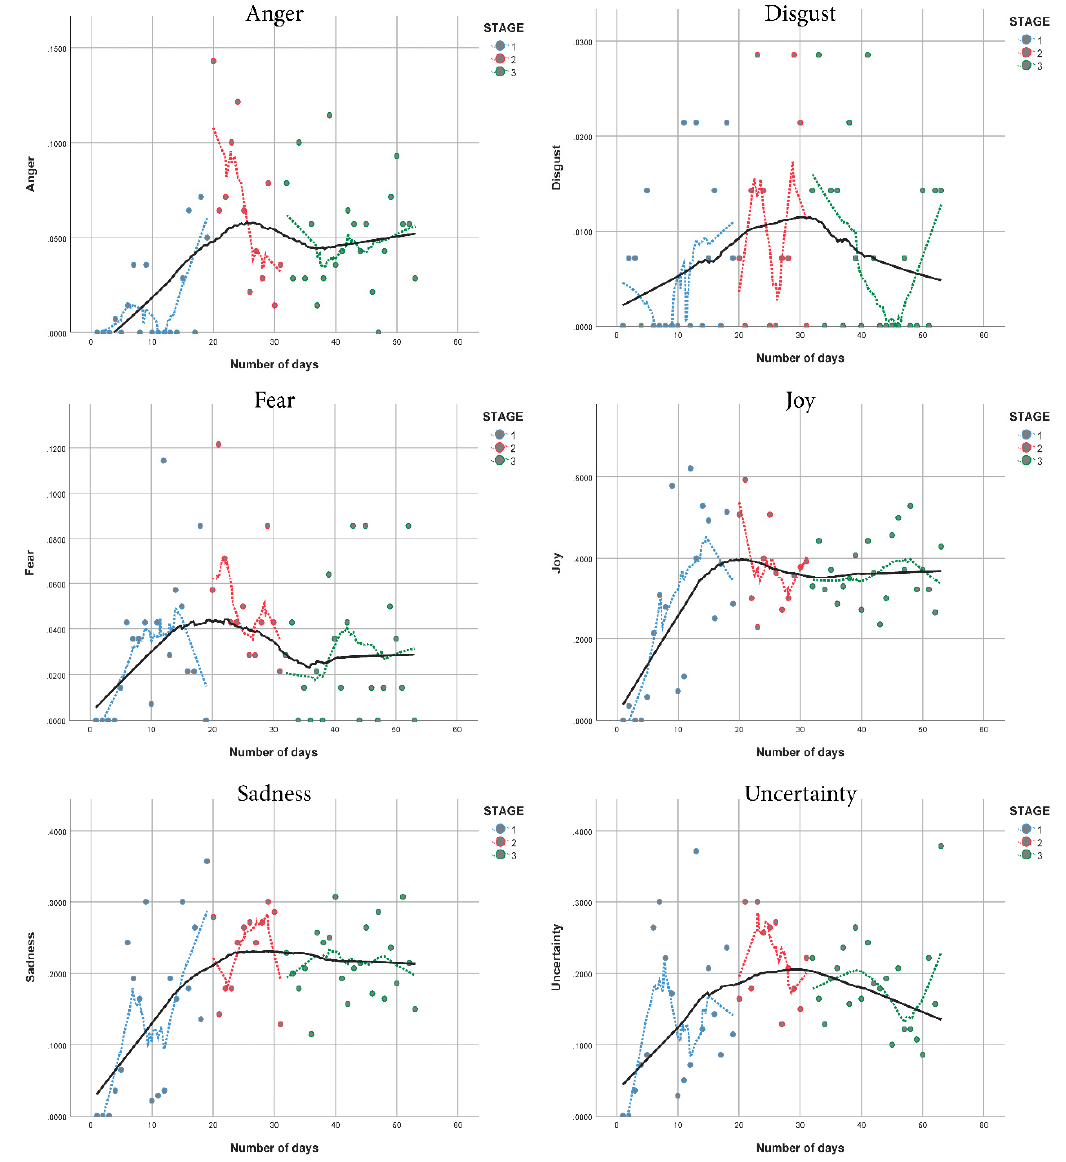
Figure 2. Hierarchical linear smooth kernel regression of the emotional response time series.